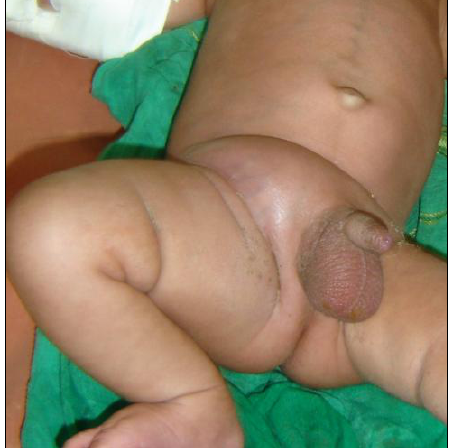
Figure 2: Swelling over the right inguinal region as the presenting feature of ilio-psoas